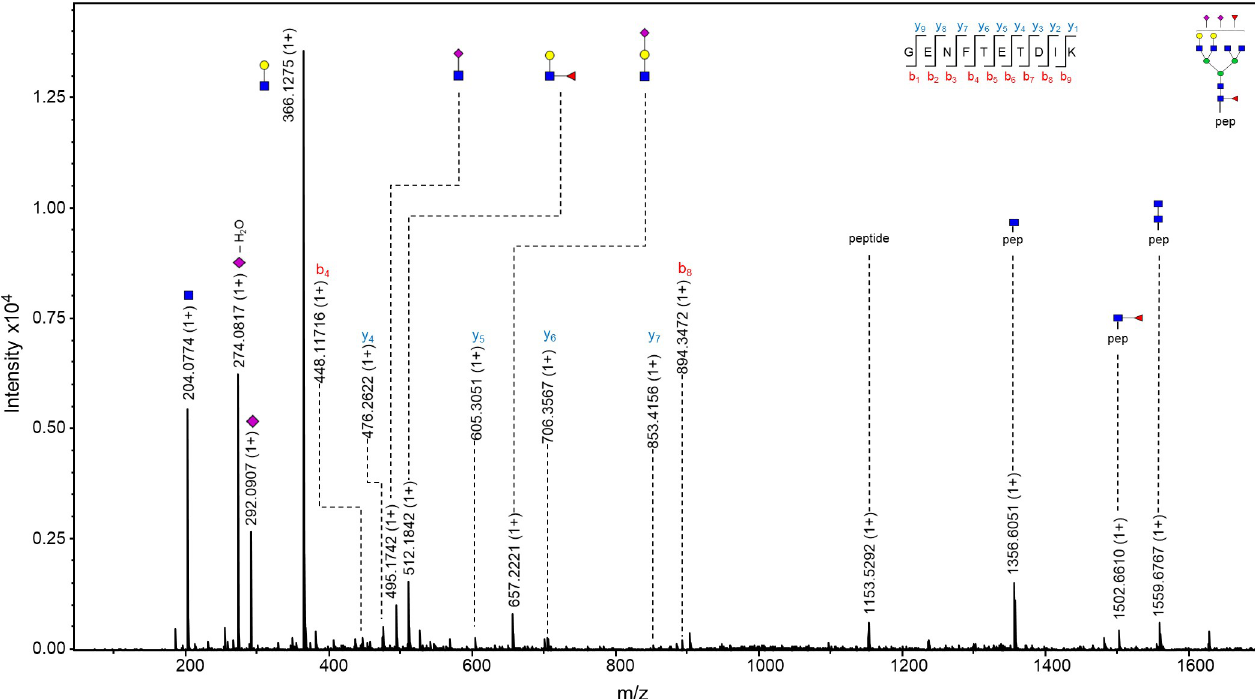
Fig 8. MS/MS spectrum of N-200 glycopeptide from 21K slow prion strain. The glycopeptide represented in the figure is the one carrying N-glycan with a composition H5N6S2F2. The usual fragments of glycan-specific marker ions are represented, additionally with a fragment of m/z value 495.1742 (1+), suggesting the presence of 6sLeC. Also, y ions confirming the amino acid sequence of the N-200 peptide and fragments of the peptide backbone with the N- glycan are visible. Blue square– N -acetylglucosamine (GlcNAc), green circle–mannose (Man), red triangle–fucose (Fuc), yellow circle–galactose (Gal), purple diamond– N -acetylneuraminic acid